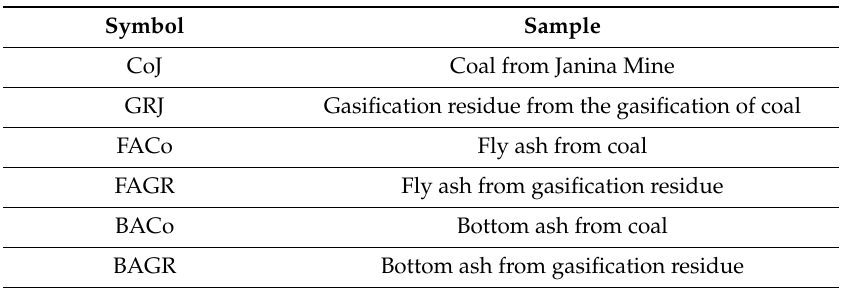
Table 1. Symbols of